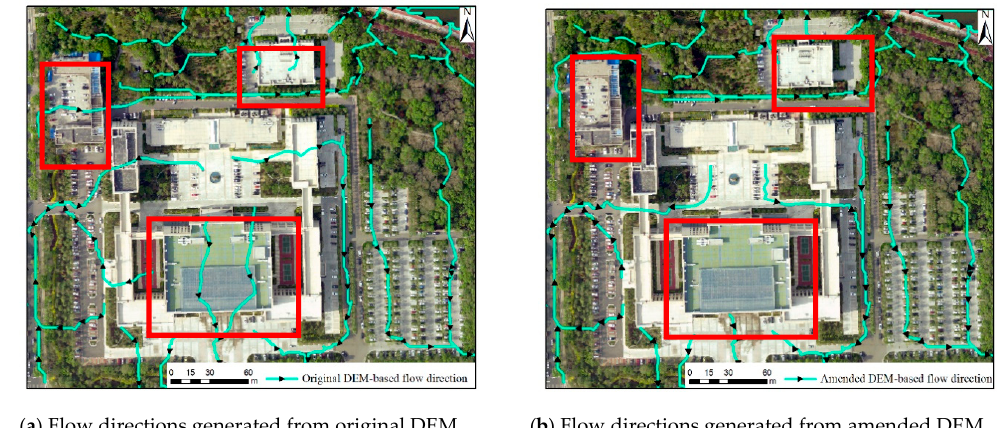
Figure 13. Flow directions based on the original DEM ( a ) and amended DEM ( b ).